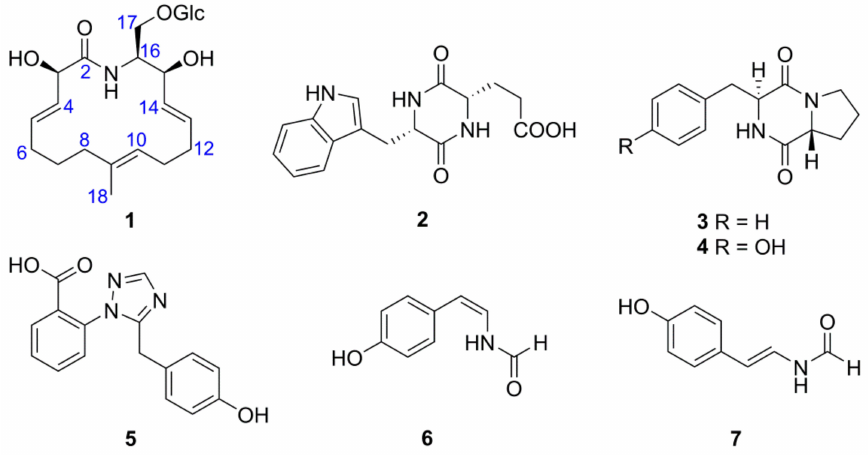
Figure 1. Chemical structures of compounds 1 – 7